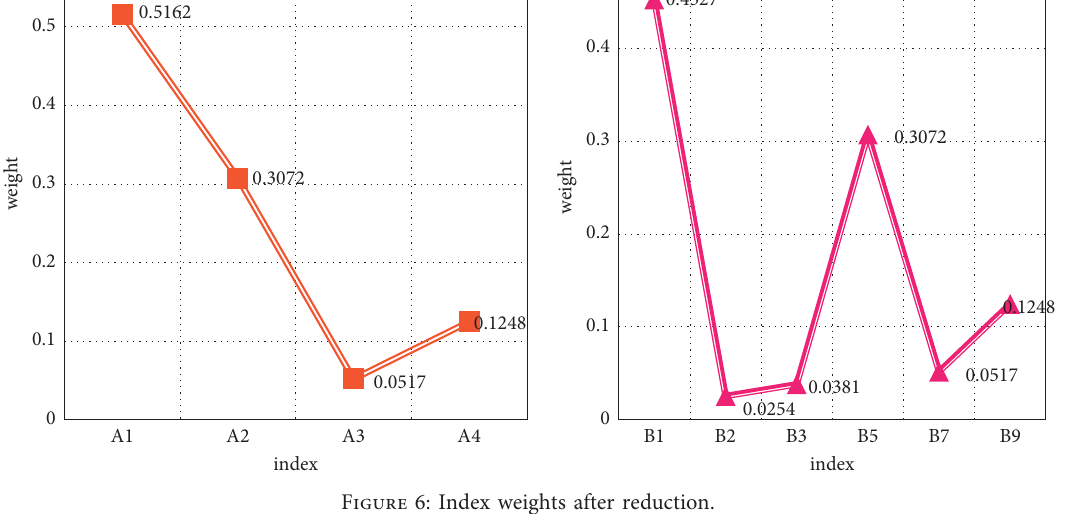
Figure 6: Index weights after reduction.